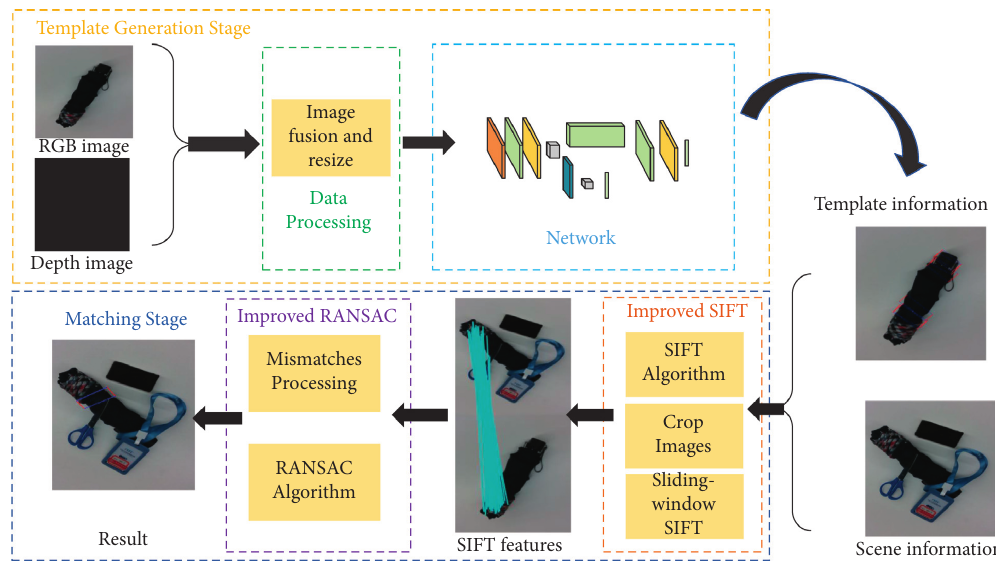
Figure 2: System diagram of our grasp detection algorithm. The template generation stage uses the network and template images to generate template information. For each scene image, the algorithm connects the scene image with template information in matching stage using a matching algorithm and obtains grasp rectangles for the target object in occluded condition.